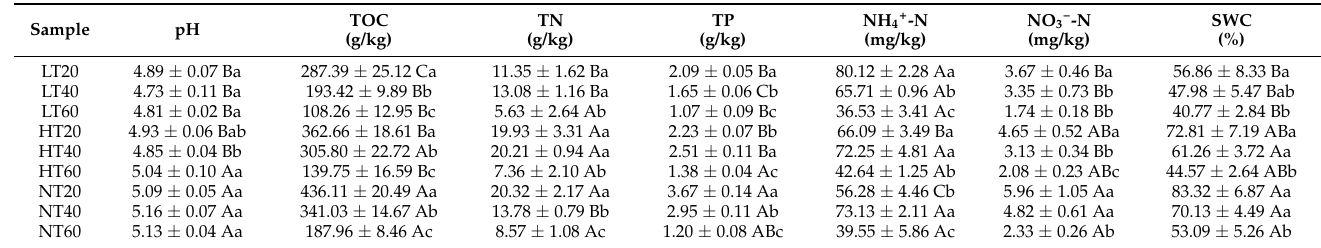
Table 1. Soil physicochemical properties of different peatland types at three depths.